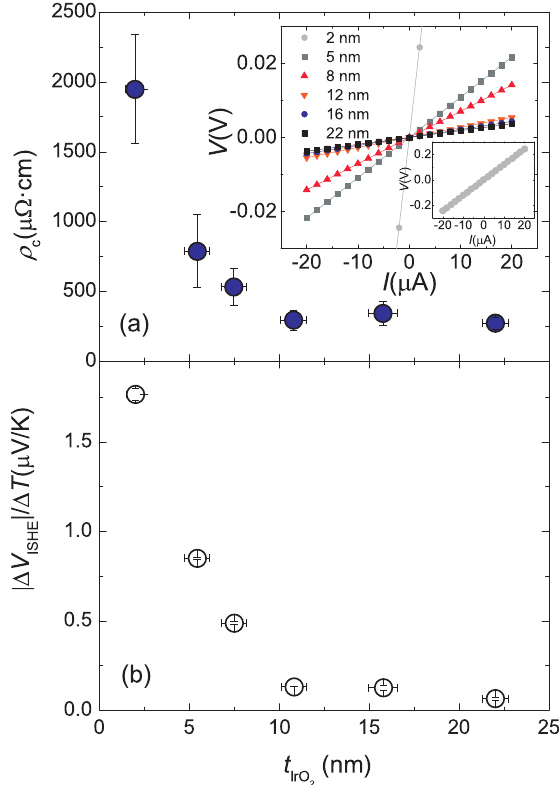
Figure 2. ( a ) Longitudinal resistivities of samples. The V ( I ) characteristic curves measured to determine the electrical resistances of the IrO 2 thin films are displayed in the inset. The V ( I ) characteristic curve of the thinner sample is zoomed out; ( b ) Voltage detected via the ISHE from LSSE